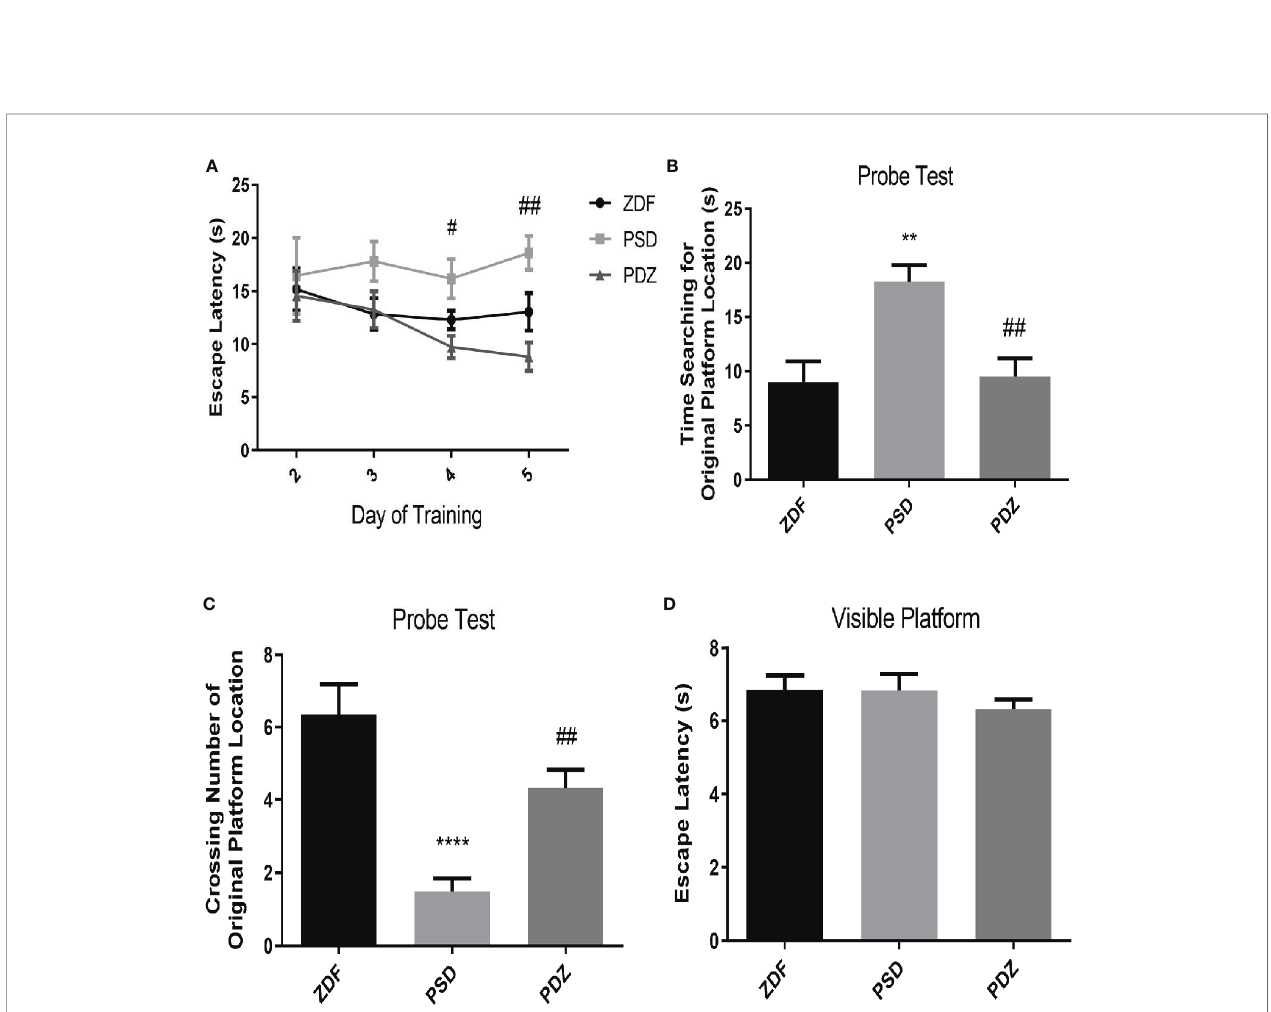
FIGURE 5 | Effect of ZBPYR on cognitive impairment in the Morris water maze (MWM) test. The escape latencies of the animals were analyzed in the training trials (A) . Performance in the probe test was analyzed, including time searching for the original platform location (B) and number of crossings over the original platform location (C) . Escape latency in the visible platform version of the MWM test was also analyzed (D) . Bars represent the mean ± SEM of 6 rats per group. ** P < 0.01, **** P < 0.0001, PSD group vs. ZDF group; # P < 0.05, ## P < 0.01, PDZ group vs. PSD